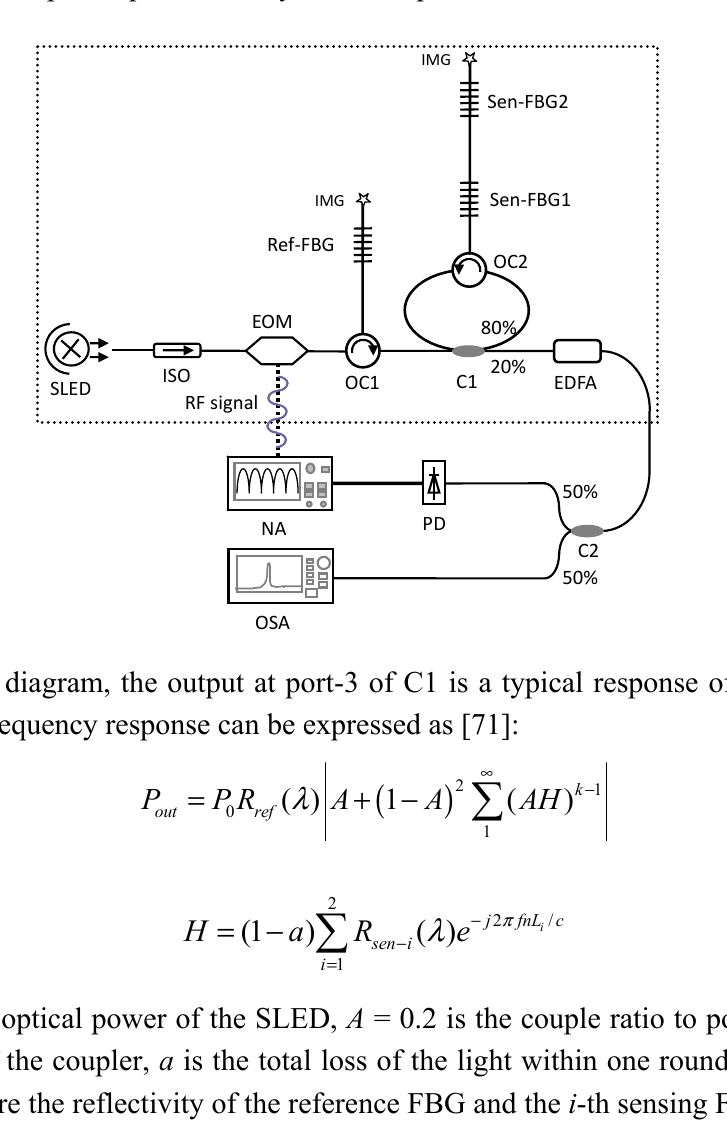
Figure 18. The FBG sensor interrogation system. ISO: isolator, IMG: index-matching glue; superluminescence diode: SLED; electro-optic modulator: EOM; coupler: C1, C2; optical circulator: OC2; sensing FBGs: Sen-FBG1, Sen-FBG2; erbium-doped